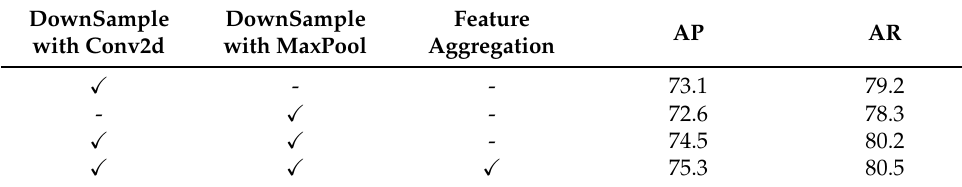
Table 3. Ablation experiment of the GradualEmbedding